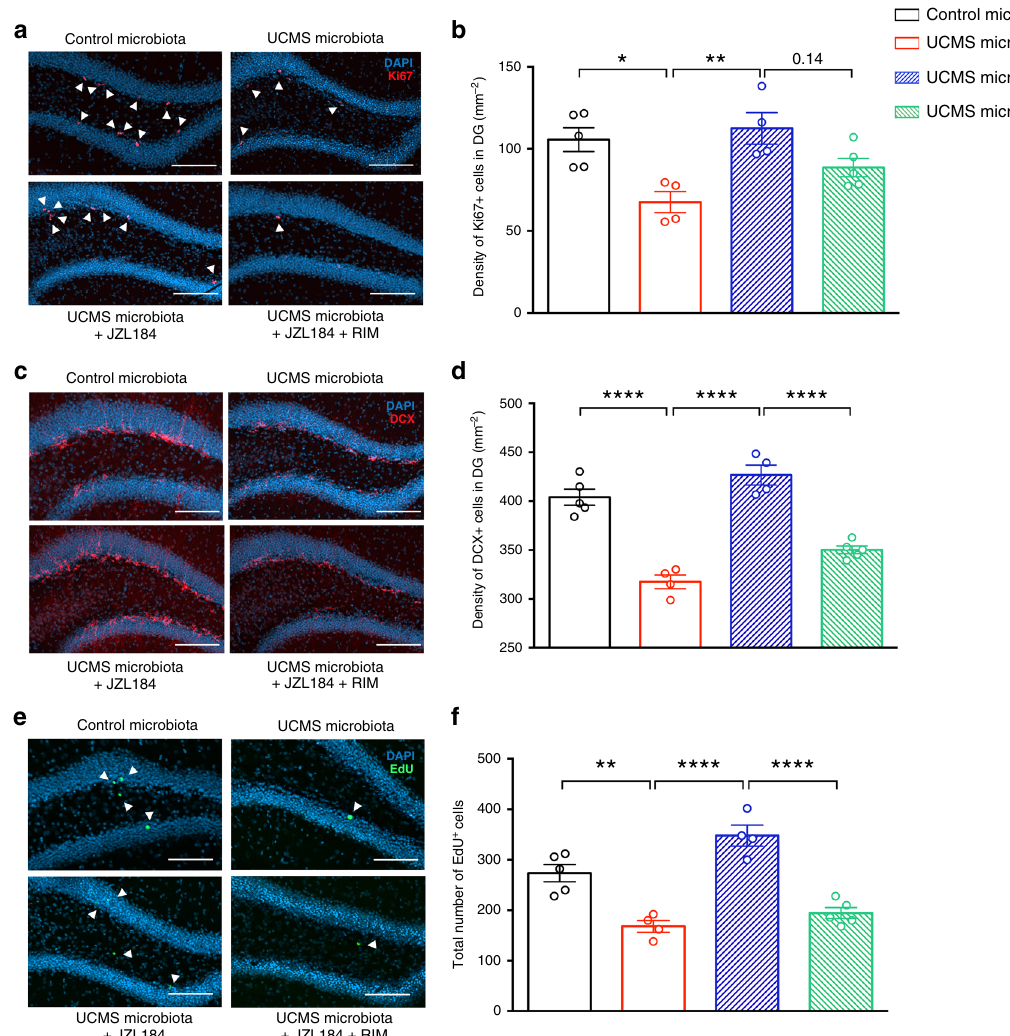
Fig. 4 Restoration of the eCB pathway normalizes hippocampal neurogenesis. a Representative images of Ki67 staining (red) in the DG of the hippocampus, counterstained with DAPI (blue). b Quantitative evaluation of the density of Ki67 + cells for Control microbiota-recipient mice ( n = 5), UCMS microbiota-recipient mice ( n = 4), UCMS microbiota-recipient mice treated with JZL184 ( n = 4), and UCMS microbiota-recipient mice treated with JZL184 and rimonabant ( n = 5). (Control microbiota- vs UCMS microbiota-recipient mice, P = 0.0111; UCMS microbiota-recipient mice vs UCMS microbiota-recipient mice + JZL184, P = 0.0048; UCMS microbiota-recipient mice + JZL184 vs UCMS microbiota-recipient mice + JZL184 + RIM, P = 0.1402). c Representative images of DCX staining (red) in the DG of the hippocampus, counterstained with DAPI (blue). d Quantitative evaluation of the density of DCX + cells for Control microbiota-recipient mice ( n = 5), UCMS microbiota-recipient mice ( n = 4), UCMS microbiota-recipient mice treated with JZL184 ( n = 4), and UCMS microbiota-recipient mice treated with JZL184 and rimonabant ( n = 5). (Control microbiota- vs UCMS